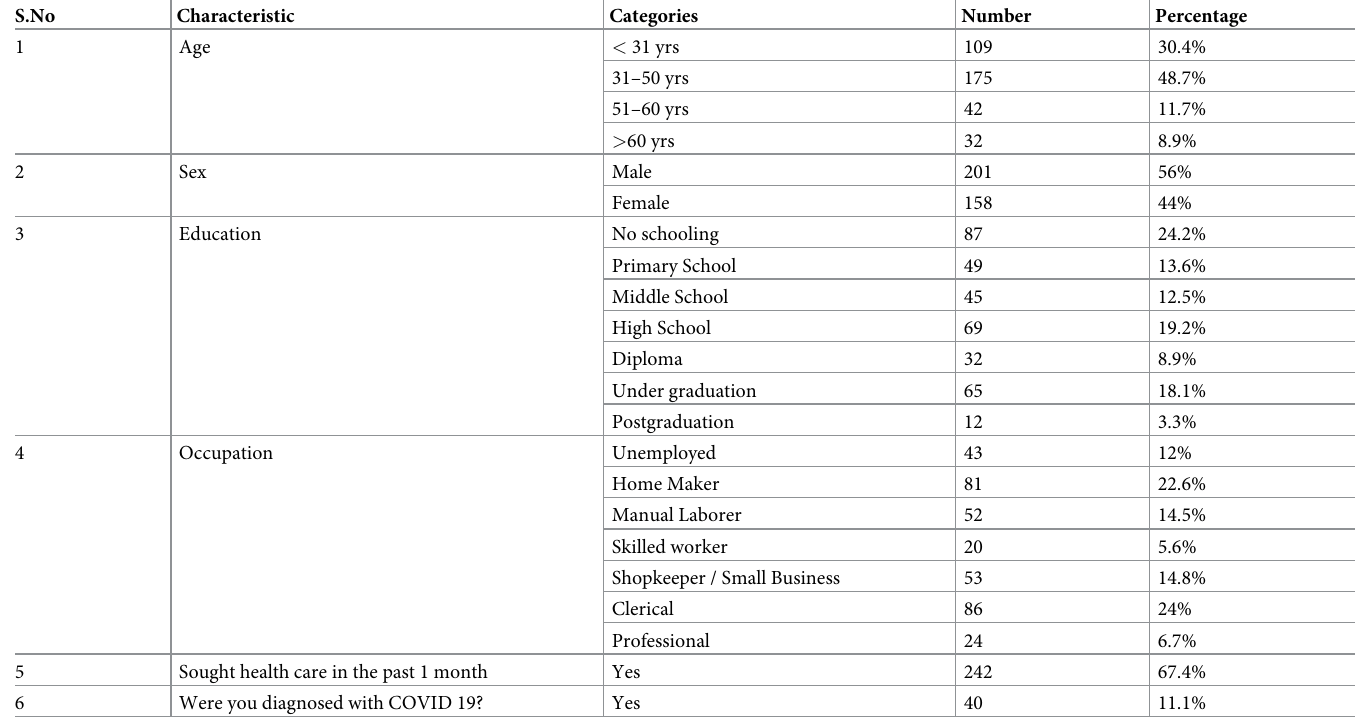
Table 1. Characteristics of the study